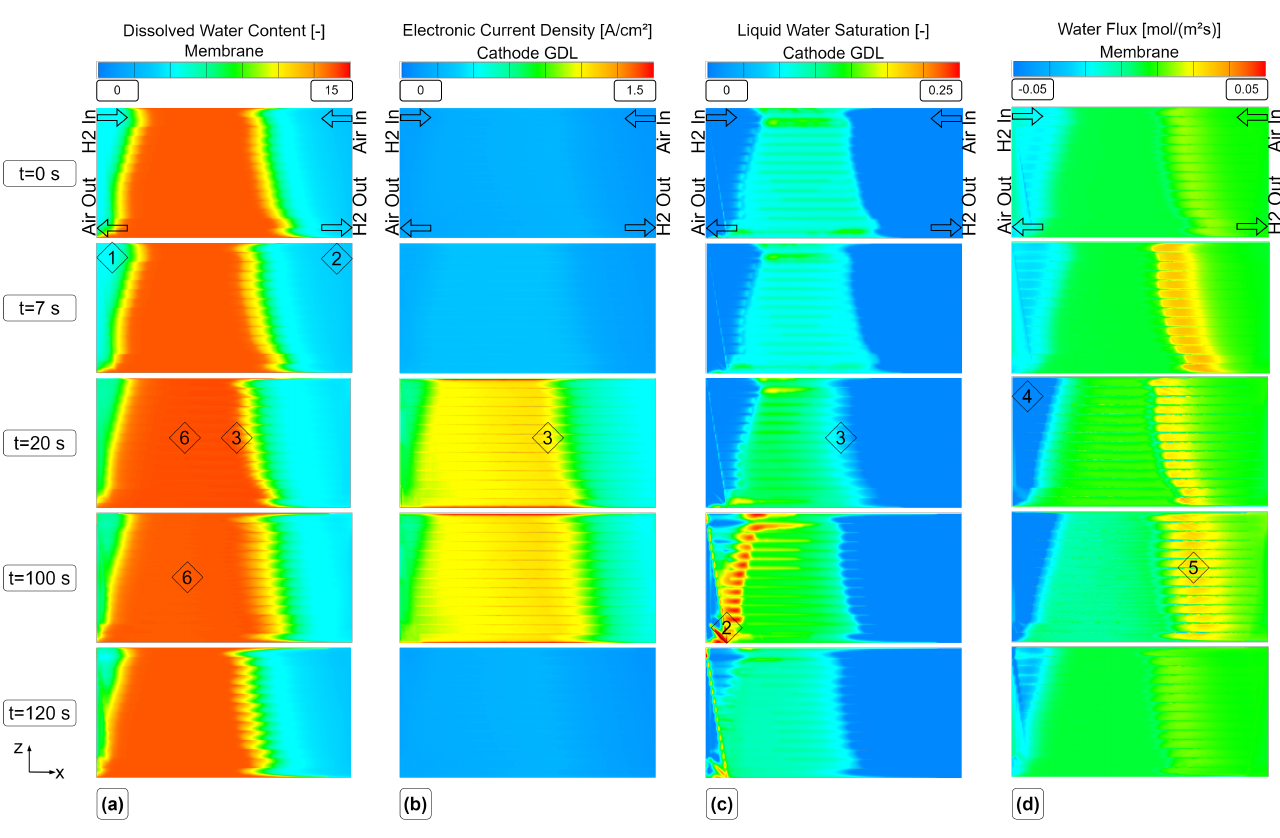
Figure 11. The 3D results from simulation with HCM and DVS8 L3 at 6 different times, t = 0 s, 7 s, 20 s, 100 s, 120 s, were extracted. ( a ) Dissolved water content of the membrane, cut in the middle ( y = 0). ( b ) Electronic current density in the middle of the cathode GDL. ( c ) Liquid water saturation in the middle of the cathode GDL. ( d ) Dissolved water flux in the middle of the